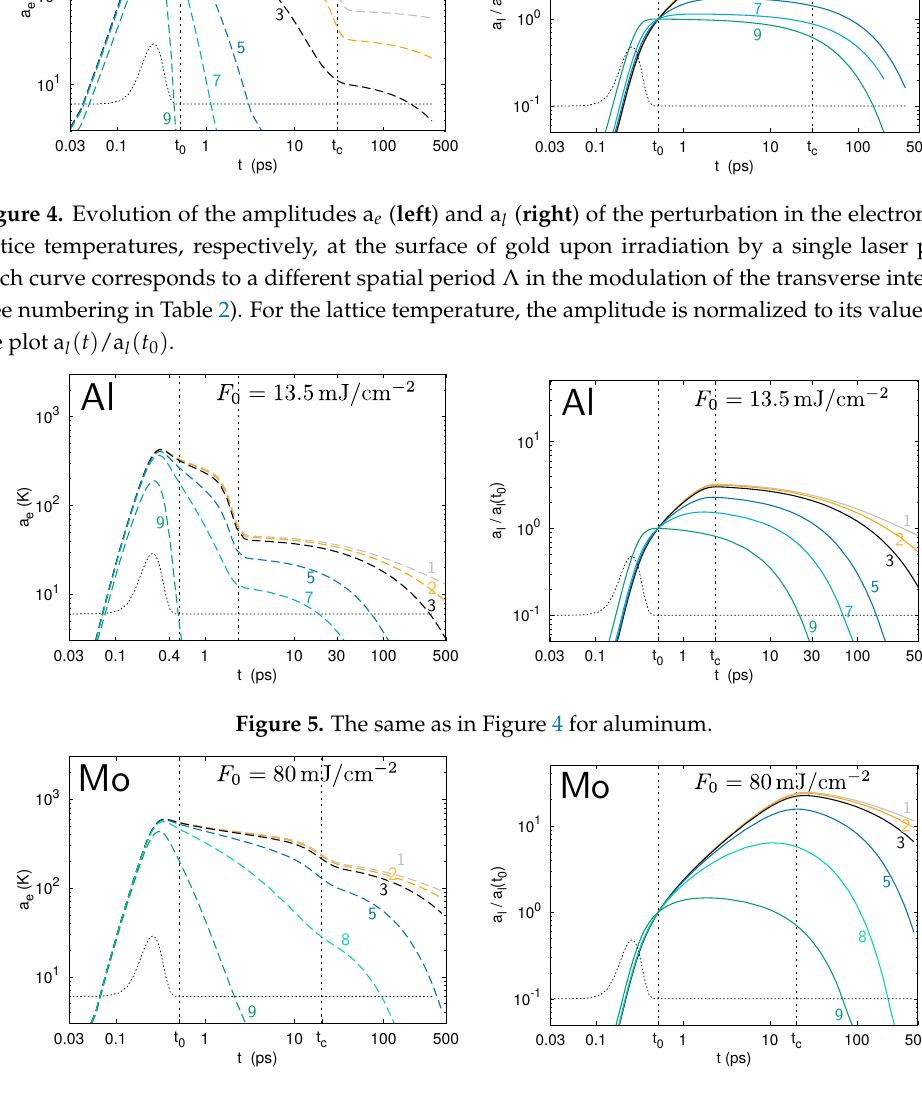
Figure 6. The same as in Figures 4 and 5 for